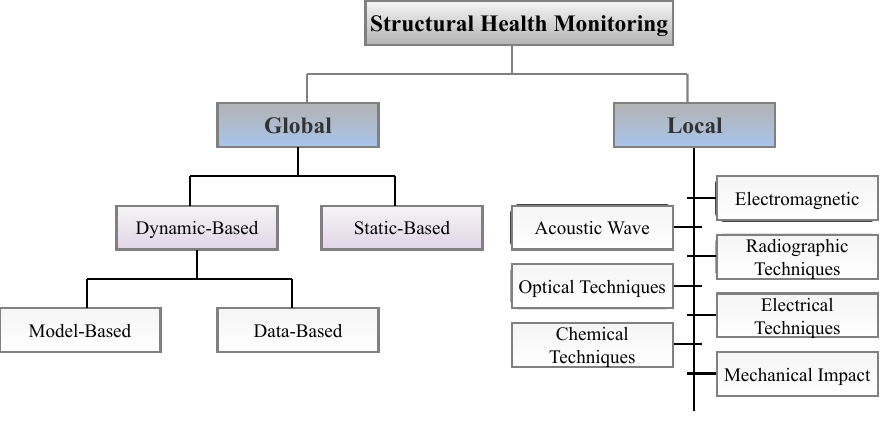
Figure 5. Classification of SHM